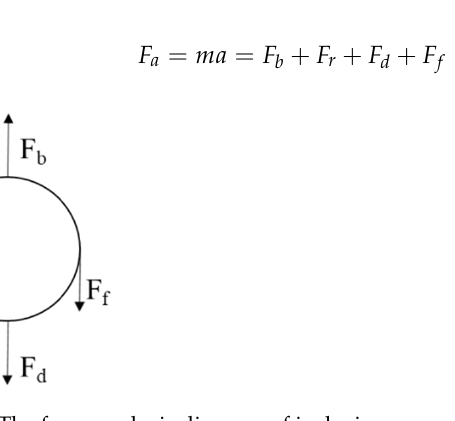
Figure 10. The force analysis diagram of inclusions.